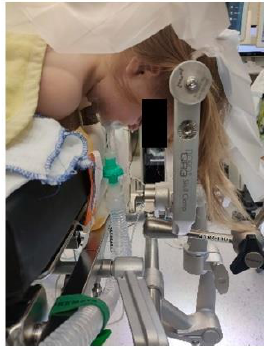
Figure 3. Prone positioning with lateral soft rolls to elevate and support lateral chest wall, tubus fixation.